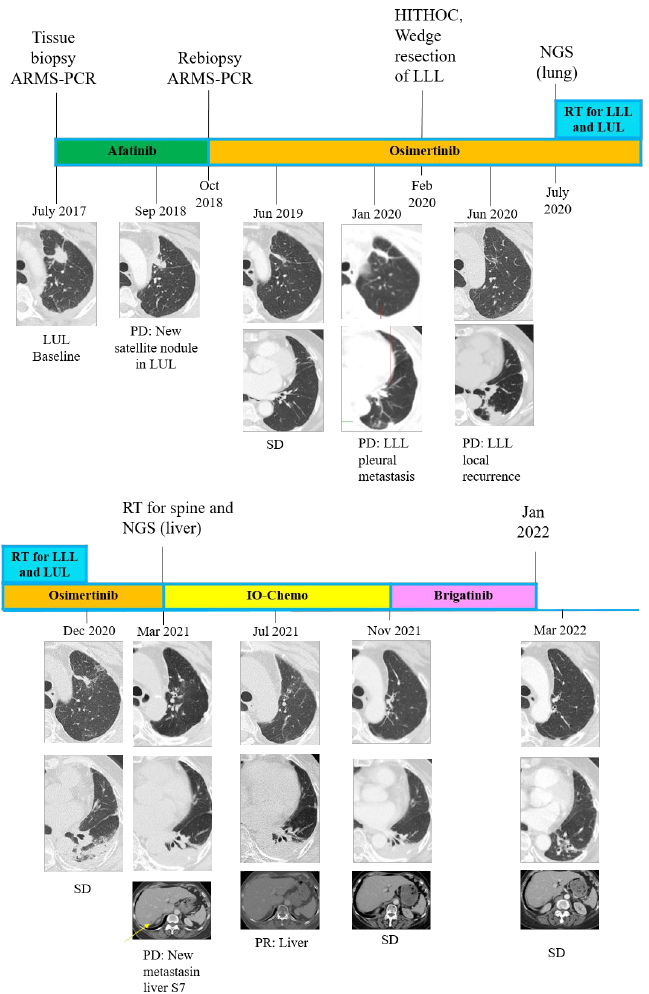
Figure 1. Schematics showing a timeline for the treatment course. Computed tomography (CT) showed a clinical response to epidermal growth factor receptor tyrosine kinase inhibitors (e.g., afatinib, osimertinib) and immune-oncology chemotherapy (IO-Chemo) treatment. The patient had a new satellite nodule in the left upper lobe (LUL) after 14 months of afatinib treatment. The patient had stable disease after osimertinib treatment for two months, but she eventually experienced progressive disease with pleural metastasis in the left lower lobe (LLL) after receiving osimertinib for 15 months. Thus, hyperthermic intrathoracic chemotherapy (HITHOC) and wedge resection of the pleural nodule were performed for local progression in February 2020. However, progression of LUL and LLL was found, so she underwent radiation therapy for lung lesions and remained stable for the next eight months. Subsequently, the disease metastasized to C6, C7, and T2 vertebrae and segment seven (S7) of the liver. After radiation therapy for vertebrae and four months of immunochemotherapy, regression of the liver nodule and C-spine tumor were observed. However, a new skull (parietal bone) metastasis was identified on brain, and brigatinib was then administered to treat the skull bone metastasis (Showed in Figure 4). During three months of brigatinib treatment, the lung lesion did not deteriorate, and complete response of the skull metastasis was observed. PD, progressive disease; SD, stable disease; PR, partial response; ARMS-PCR, amplification refractory mutation system–polymerase chain reaction; HITHOC, hyperthermic intrathoracic chemotherapy; NGS, next generation sequencing; RT, radiation therapy; IO-chemo,